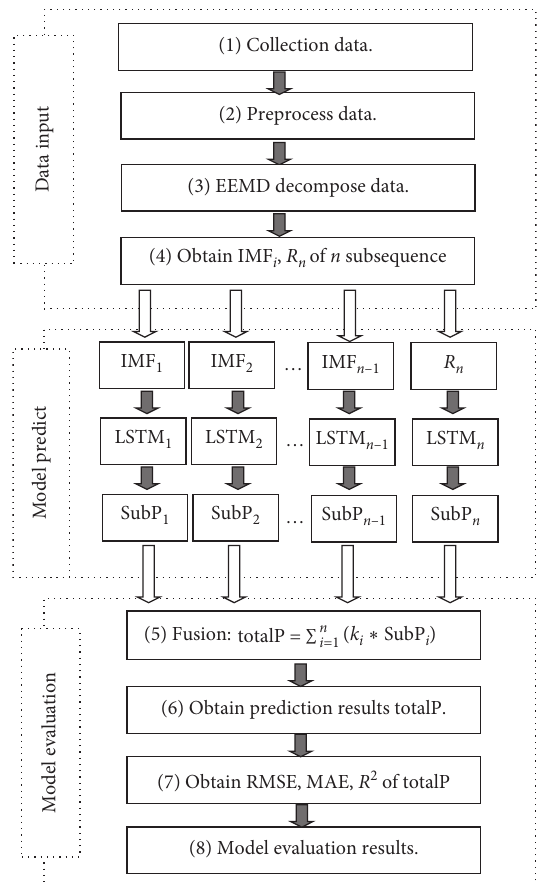
Figure 7: The data flowchart of our proposed hybrid